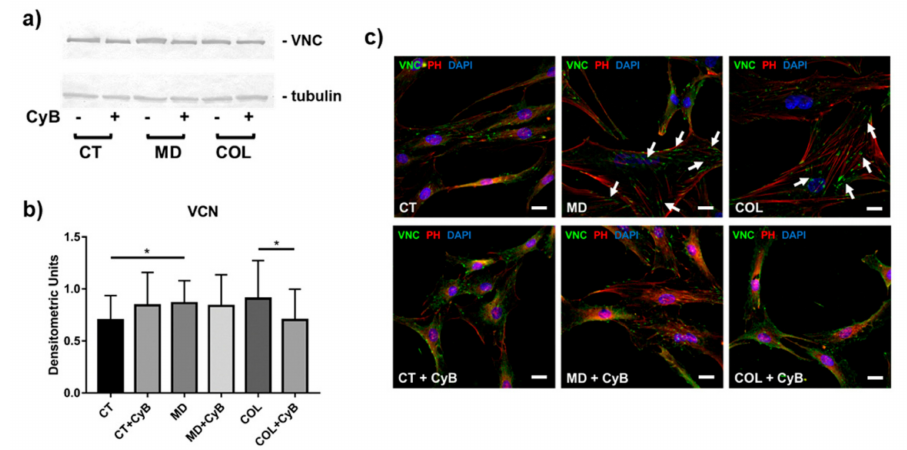
Figure 8. ( a ) Representative Western blot for VNC quantification in cell lysates obtained from tenocytes cultured on MD and COL, compared to CT, with or without CyB treatment. VNC expression was normalized on tubulin. ( b ) Bar graphs showing VCN expression after densitometric analysis of immunoreactive bands. Data are mean ± SD for at least two independent experiments. ( c ). Immunofluorescence analysis for VNC (green) in tenocytes cultured on MD and COL, compared to CT, before and after CyB treatment. Actin filaments are stained using rhodamine-phalloidin labeling. Nuclei are stained in blue by DAPI. Original magnification: 60 × . White arrows point to larger and